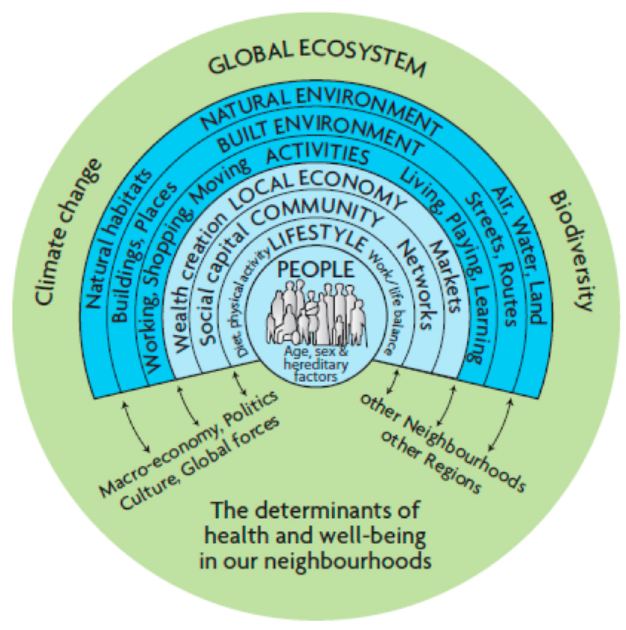
Figure 4. Health map. Source: Barton and Grant (2006).